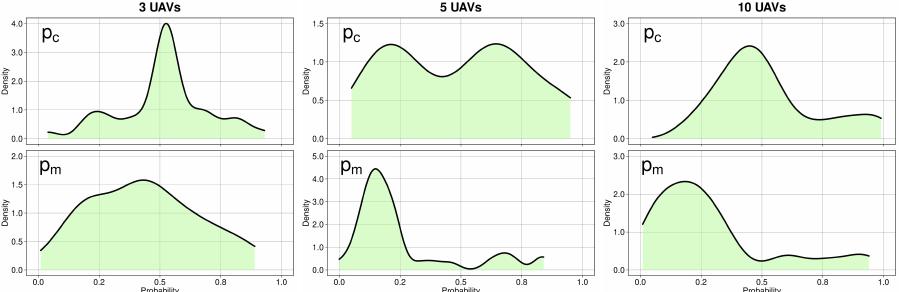
Figure 8. Parameter sampling frequency per case